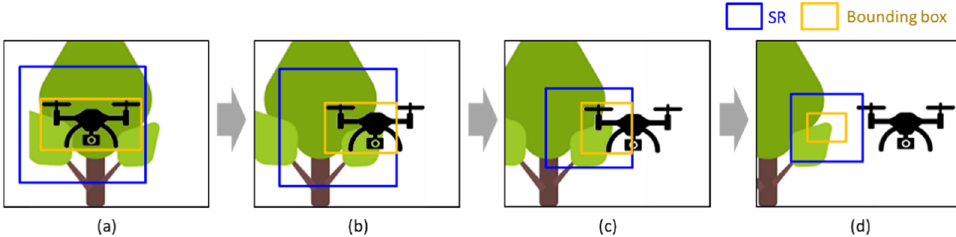
Figure 2. SR shrinkage caused by truncation. The blue box represents the SR, and the yellow box represents the tracking result calculated with a fully convolutional neural network (FCNN). ( a – d ) show sequential frames.